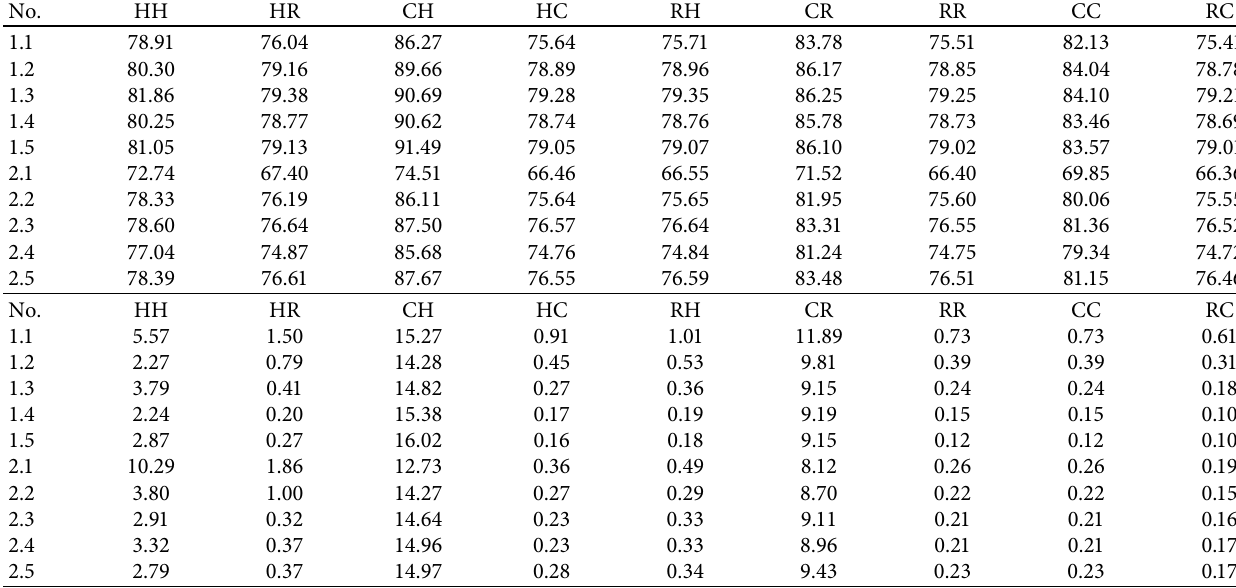
Table 15: Mean percentage qualities of the best-found schedules returned by the LS algorithms (the top table) and mean percentage improvements of the lengths of schedules returned by the LS phase with respect to the lengths of schedules returned by the initialization phase (the bottom table) for each of the ten classes of the benchmark given in [9] with cov � 90%. No. HH HR CH RC